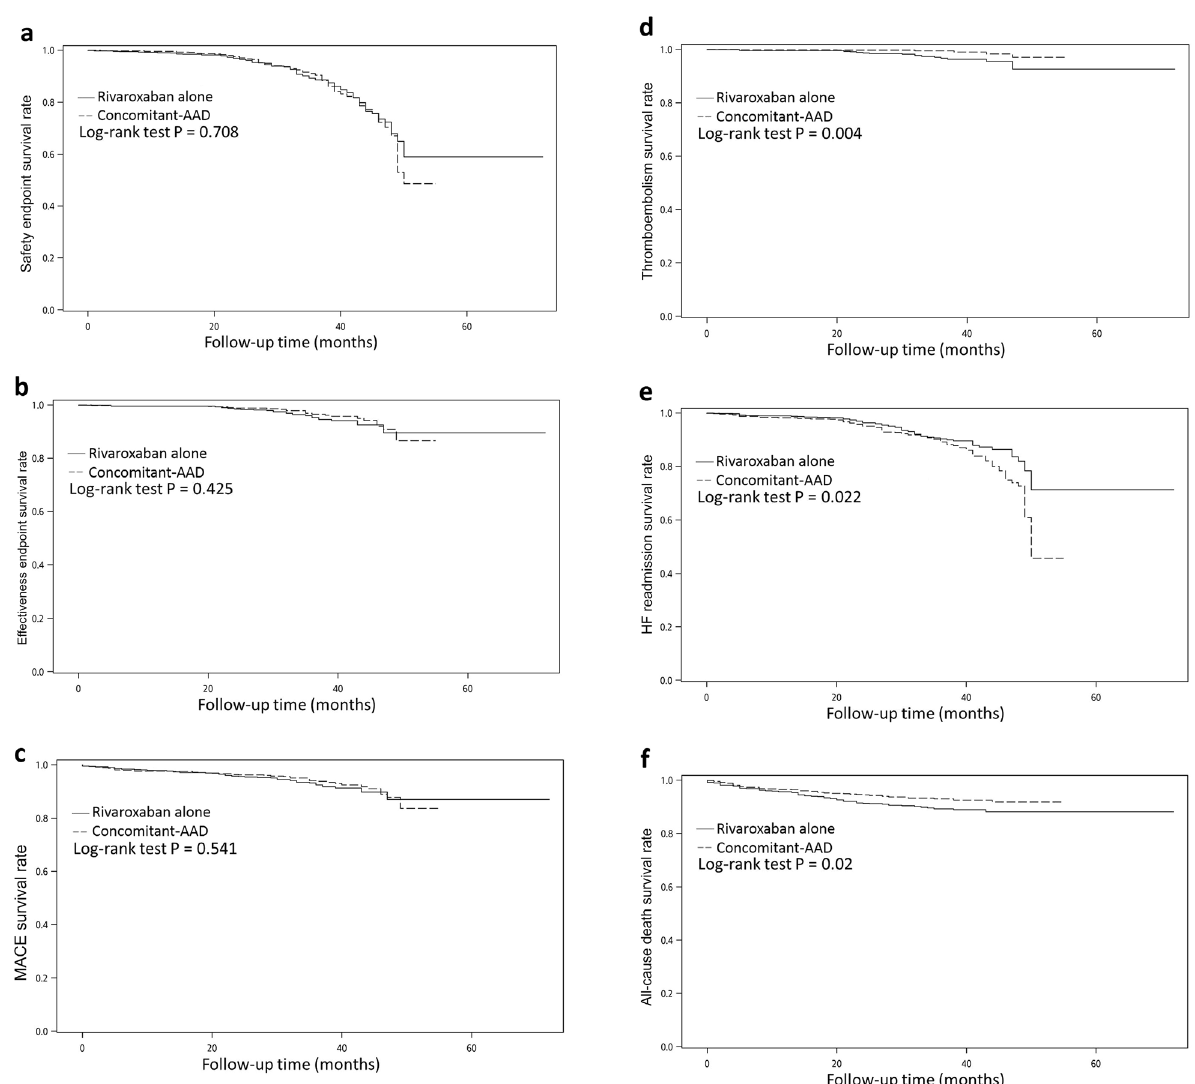
Figure 2. Survival rates for: ( a ) safety endpoint (composite of major bleeding and minor bleeding); (b) effectiveness endpoint (composite of stroke and systemic thromboembolism); ( c ) MACE; ( d ) thromboembolism; ( e ) HF readmission; ( f ) all-cause death. MACE major adverse cardiac events, HF heart